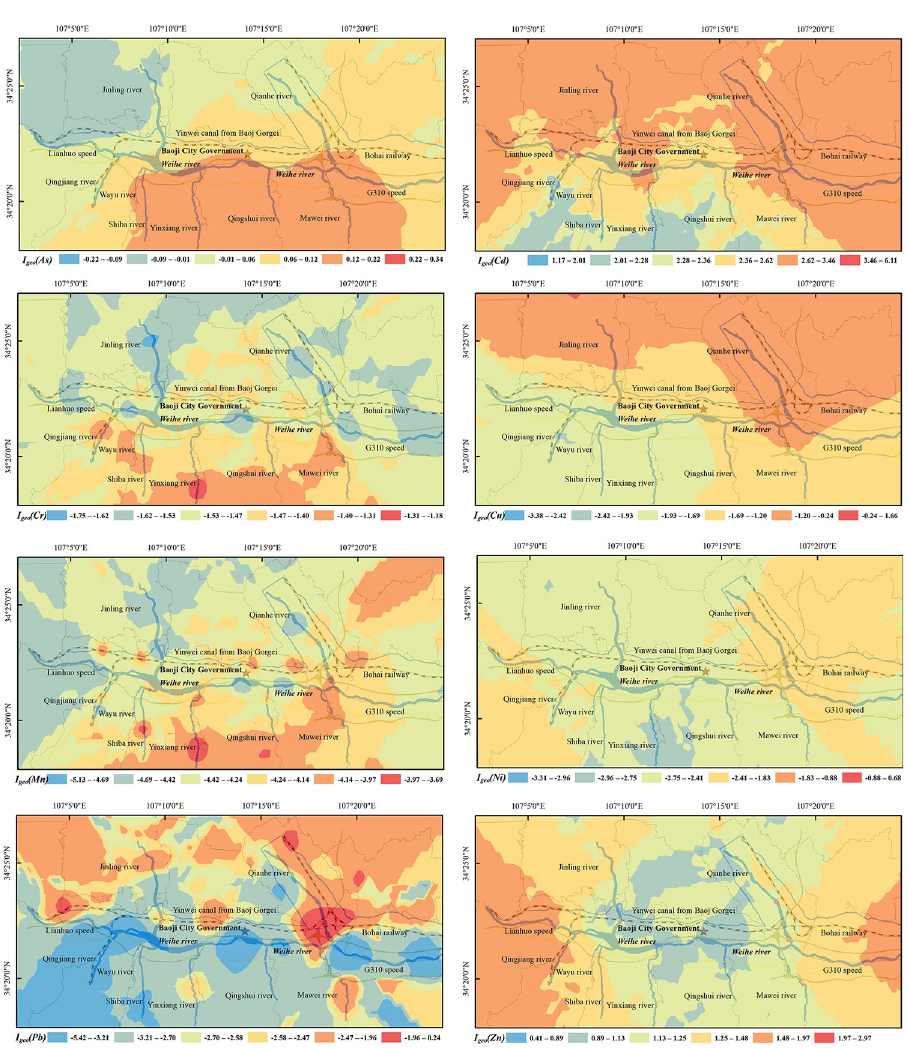
Fig 4. The spatial distribution of soil heavy metal I geo in the study